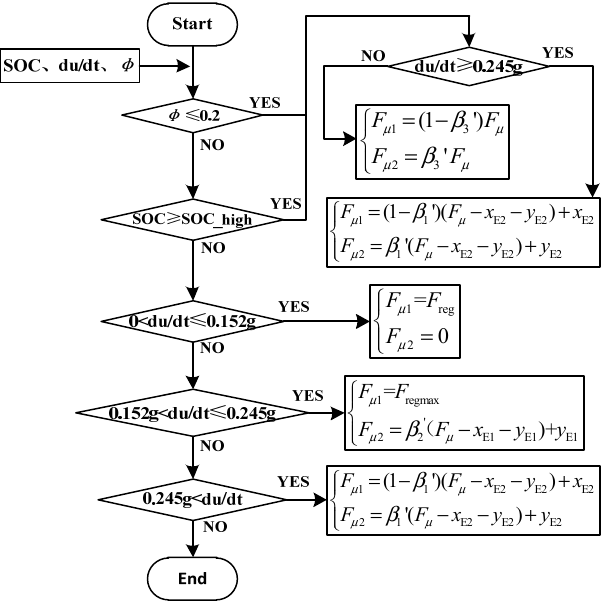
Figure 6. The adaptive distribution principle of braking force in front and rear wheels. The front wheel braking force is the sum of the motor regenerative braking force and the front wheel hydraulic braking force. When the vehicle speed is low, the speed correction factor is generally used to describe the process in which the front wheel hydraulic braking force gradually replaces the motor regenerative braking force. The speed correction factor k 1 can be expressed